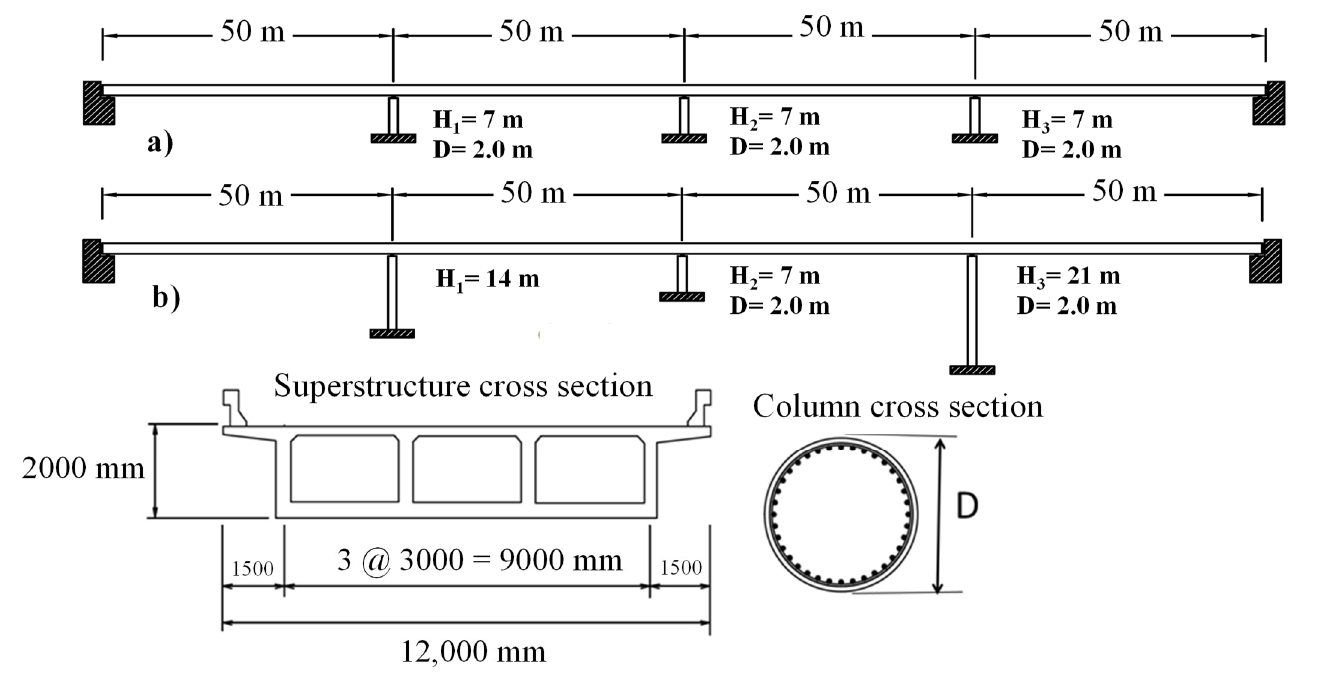
Figure 2. Bridges properties: ( a ) regular bridge; ( b ) irregular bridge.